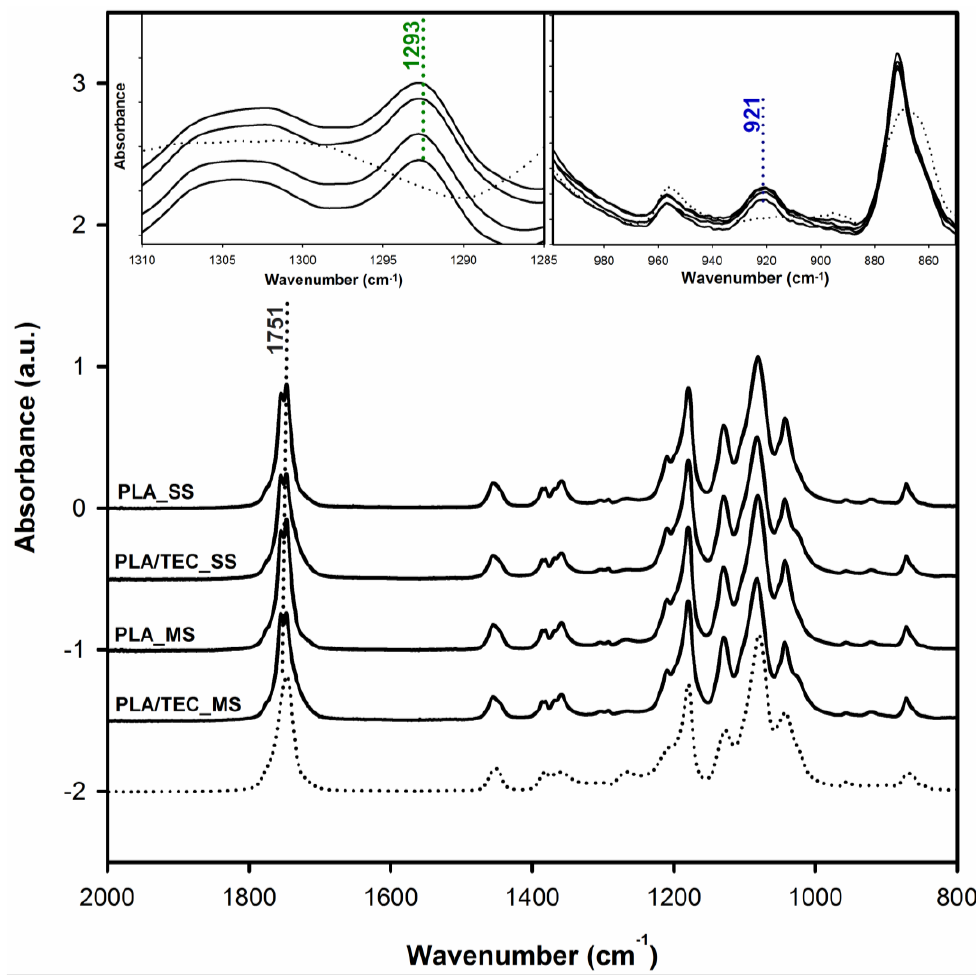
Figure 6. Fourier transform infrared (FTIR) spectra of neat PLA and PLA / TEC systems. The dotted line Figure 6. FTIR spectra of neat PLA and PLA/TEC systems. The dotted line is the spectrum of an is the spectrum of an amorphous PLA amorphous PLA sample.